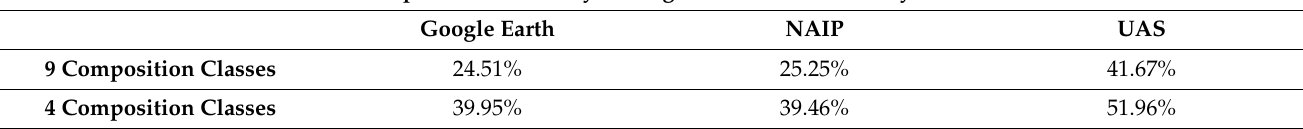
Table A2. Thematic (overall) accuracy for plot-level visual interpretations using each of the three high-spatial-resolution remotely sensed data